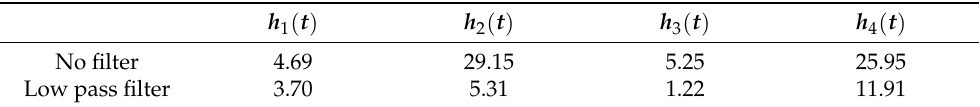
Table 4. Noise variance estimates on the h k ( t ) in the absence and presence of low-pass filtering in the case of the lower SNR value.